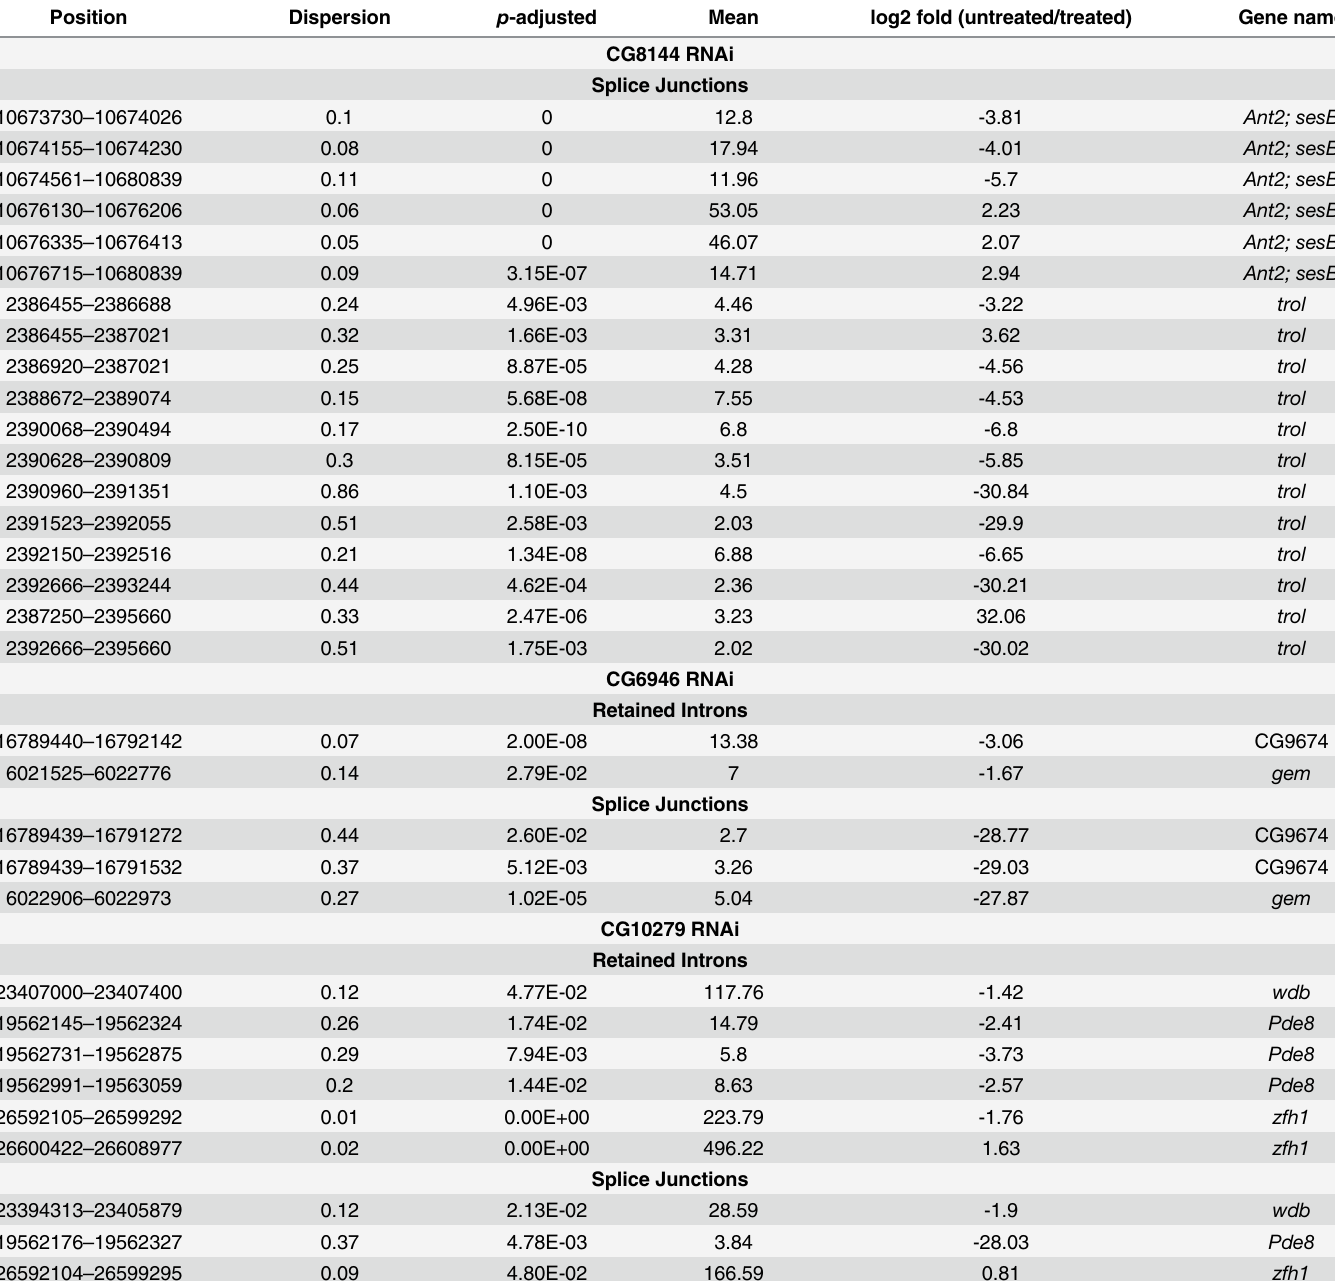
Table 2. Alternative splicing detected in the CG8144 and CG6946 RNAi experiment in Drosophila .